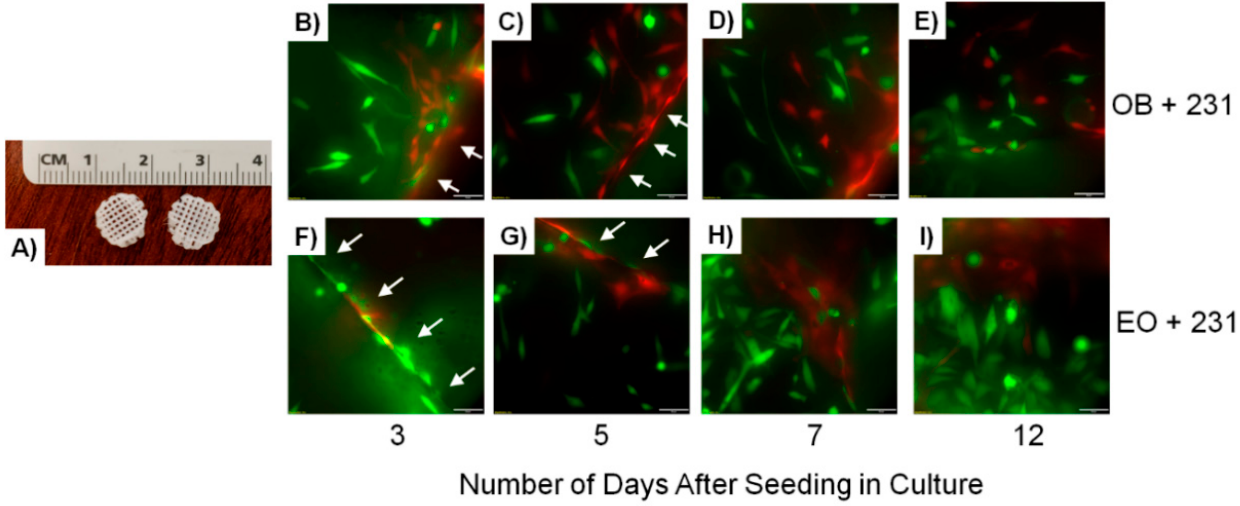
Figure 1. Co-cultures of osteoblasts and breast cancer cells attach and proliferate over time on polycaprolactone printed scaffolds. ( A ) Printed polycaprolactone scaffolds were coated with Matrigel™ then seeded with a 1:1 admix of GFP-MDA- MB-231 human breast cancer cells plus either ( B – E ) tdTomato MC3T3-E1 murine osteoblasts (OB) or ( F – I ) tdTomato murine educated osteoblast (EO) cells. Seeded scaffolds were imaged for fluorescence over the course of 12 days for cell seeding, growth, and spread on the scaffold. White arrows indicate edges of the criss-cross printed pattern of the scaffold. Scale bar on fluorescent images = 50 μ m.